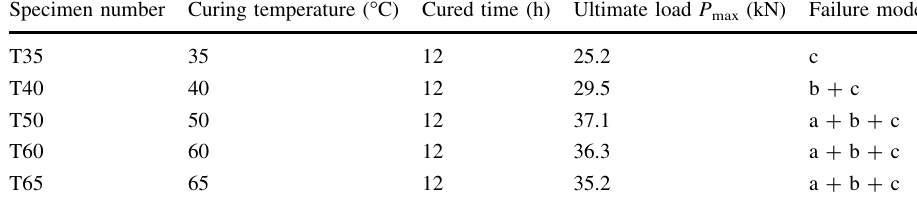
different curing temperatures